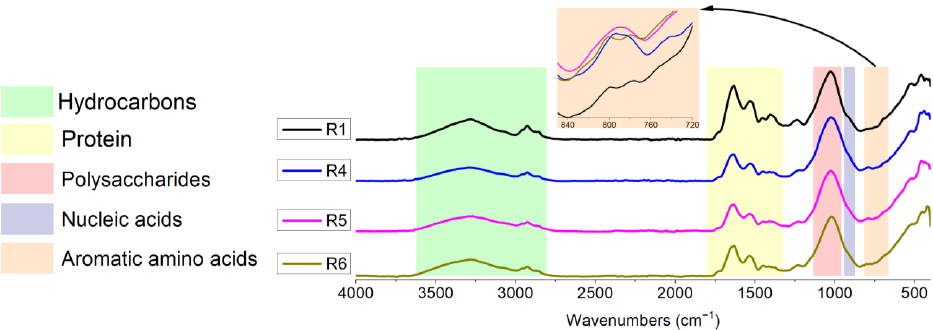
Figure 2. FTIR spectroscopy analysis of reactors after 30 min of disintegration. Conditions: R1: blank; R4: PDS (8.4 mM) + nZVI (0.2 g/L); R5: PDS (8.4 mM) + nZVI/Ag (0.2 g/L); R6: PDS (8.4 mM) + nZVI/Cu (0.2 g/L).